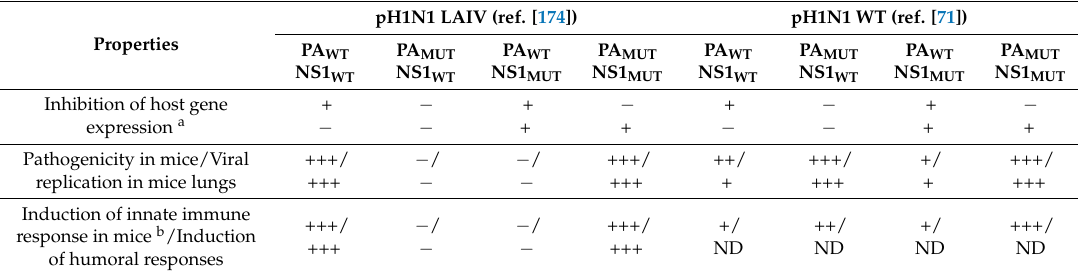
Table 3. Properties of live-attenuated influenza vaccines (LAIV) and currently circulating wild-type (WT) pH1N1